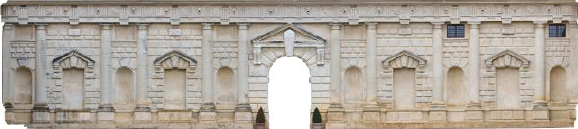
Figure 6. Courtyard of Honour internal north frontage orthophoto from Photoscan.